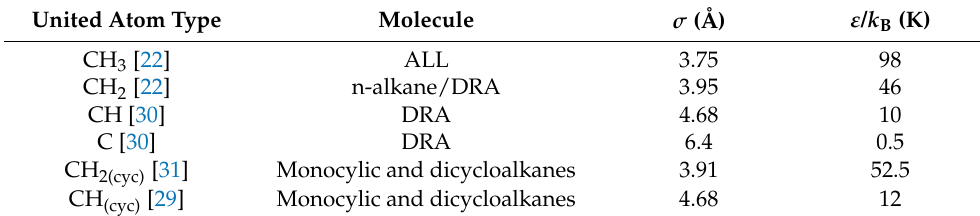
Table 2. Lennard-Jones potential parameters for the TraPPE-UA force field.